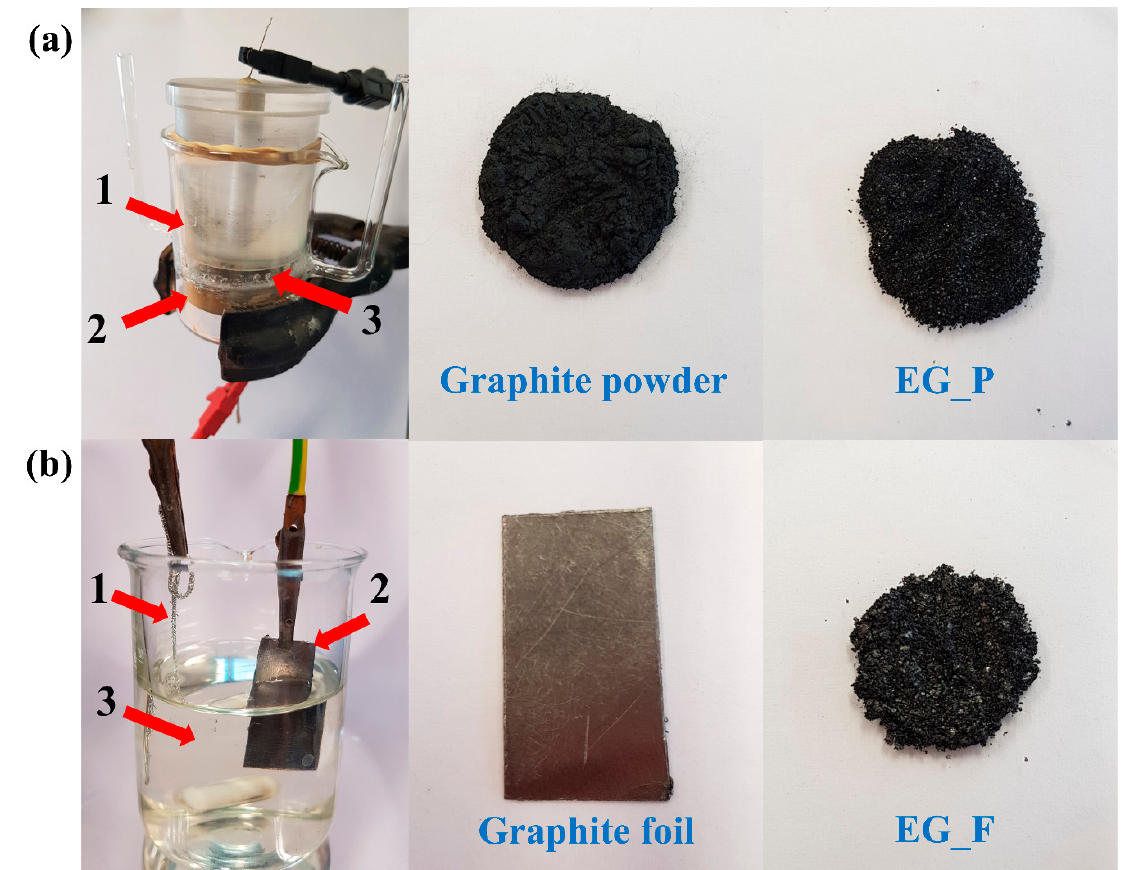
Figure 1. Experimental setup of electrochemical exfoliation technique for: (a) graphite powder, where: (1) platinum electrode (cathode), (2) platinum electrode (anode), (3) space for the electrolyte and graphite for exfoliation, image of initial graphite powder and the final graphene after electrochemical exfoliation (EG_P); (b) graphite foil, where: (1) platinum electrode (anode), (2) graphite foil (cathode), (3) electrolyte, image of initial graphite foil and the final graphene after electrochemical exfoliation (EG_F).